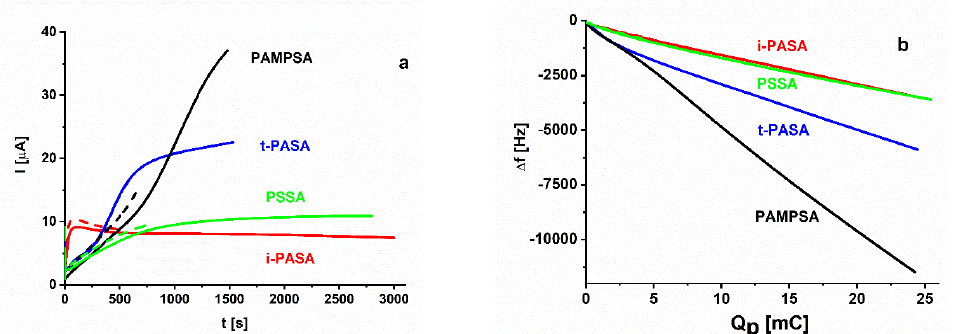
Figure 1. Electrochemical ( a ) and microgravimetric ( b ) measurements in the course of potentiostatic polymerization in the presence of PAMPSA (black), t-PASA (blue), i-PASA (red) and PSSA (green). Full and dashed lines correspond to thick and thin layers, correspondingly.